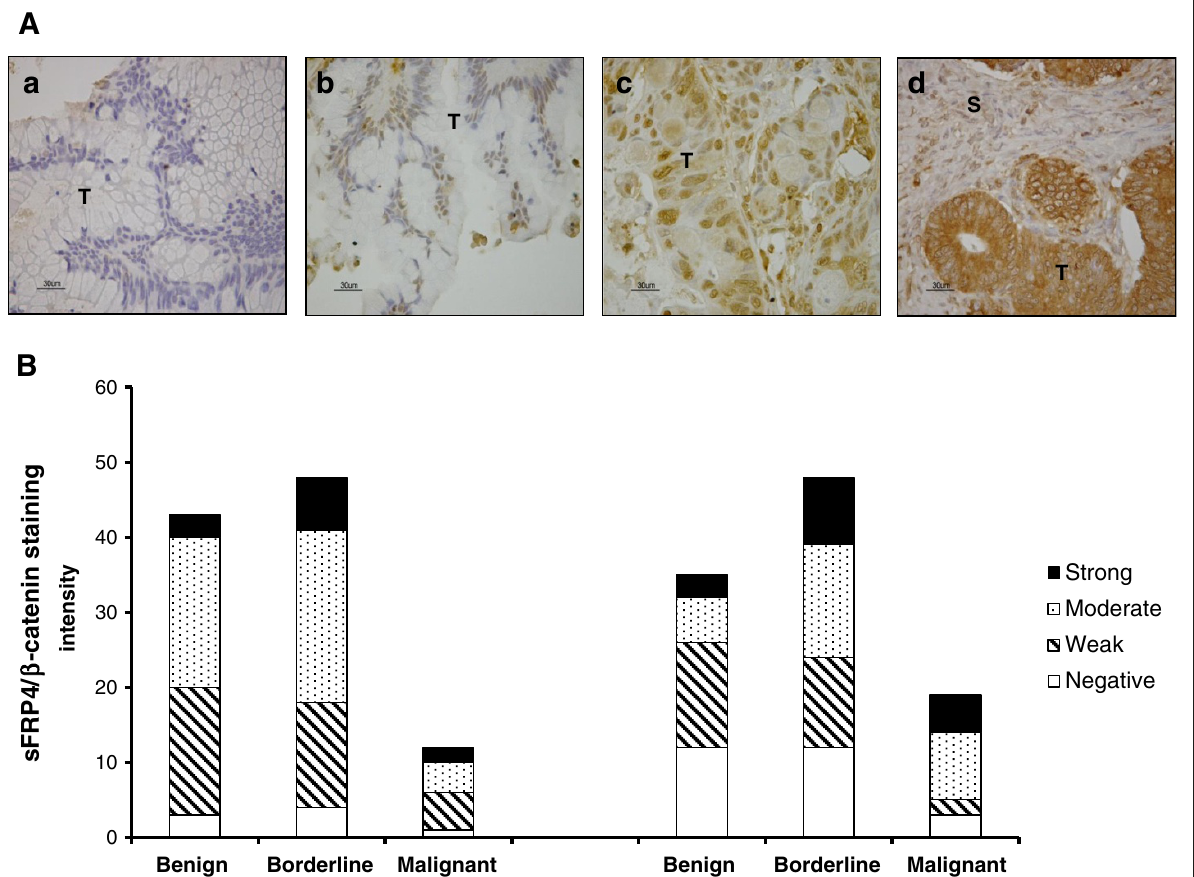
Figure 8 (A) Examples of TMA scoring based on staining intensity. Light microscope images of mucinous ovarian tumour tissue (T) and stroma (S) from the TMAs. Tissue samples expressing sFRP4 are stained brown with DAB and counterstained with haematoxylin. Images show examples of ( a ) Negative ( b ) Weak ( c ) Moderate and ( d ) Strong staining. Scale bar = 30 μ m. ( B ) Graphical representation of the staining